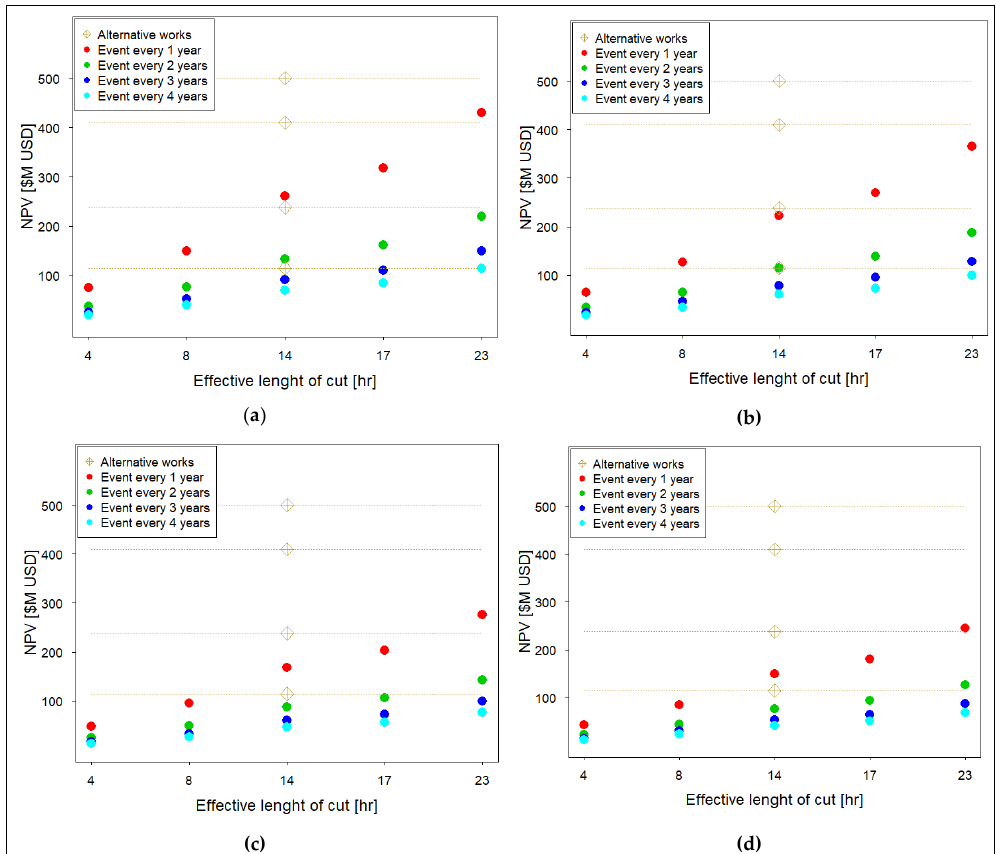
Figure 5. NPV sensitivity analysis of discount rate ( a ) r = 4%; ( b ) r = 5%; ( c ) r = 7%; ( d ) r = 8%.